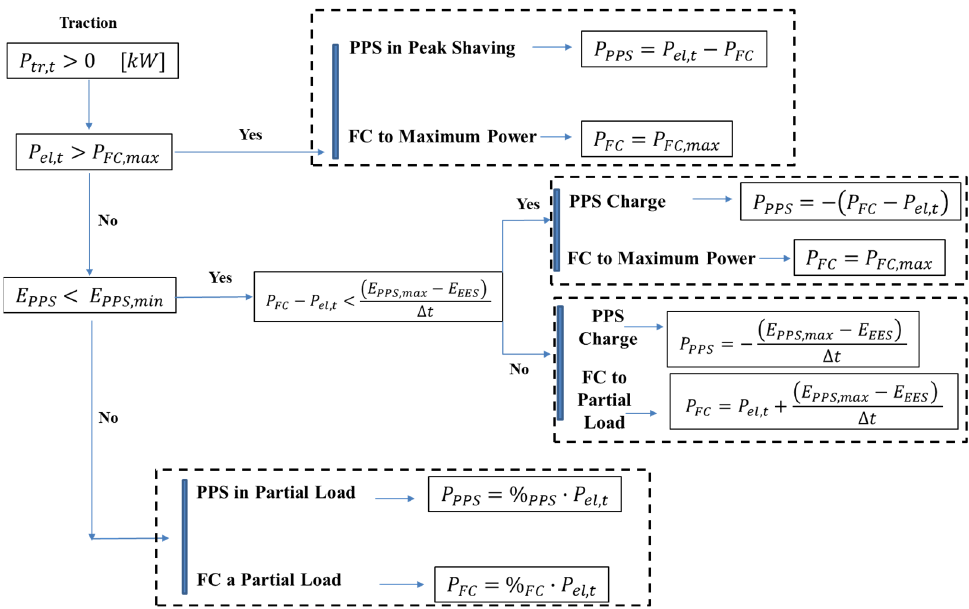
Figure 10. Traction